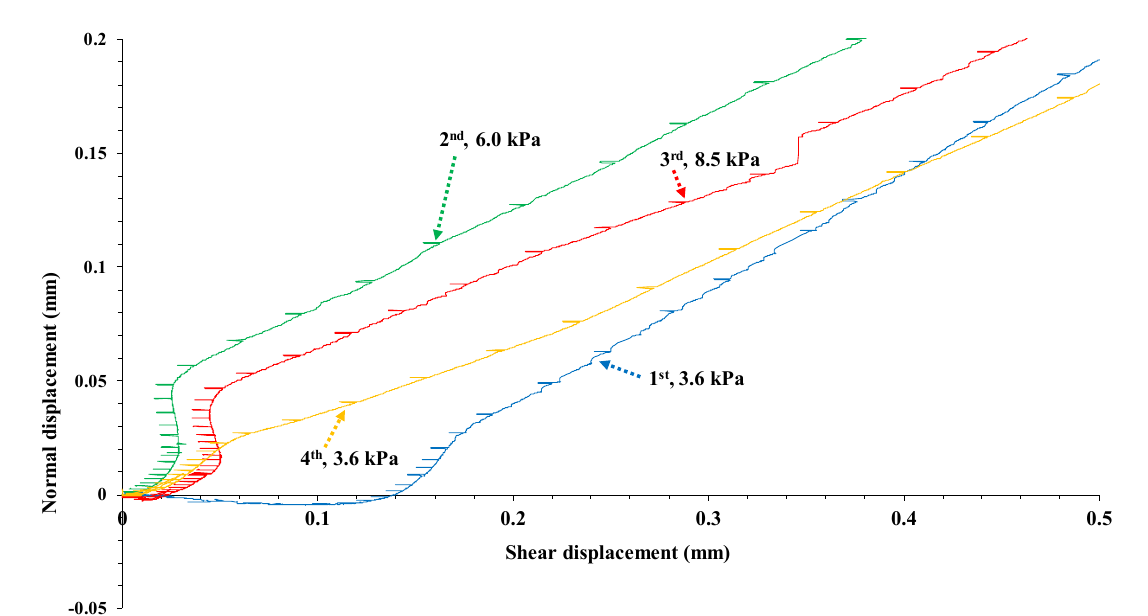
Figure 18. Transition from negative to positive values of dilation during the different stages of the large push shear test. Table 3. Shear test results for both the large (2000 mm × 1000 mm) and medium (500 mm × 250 mm) samples.